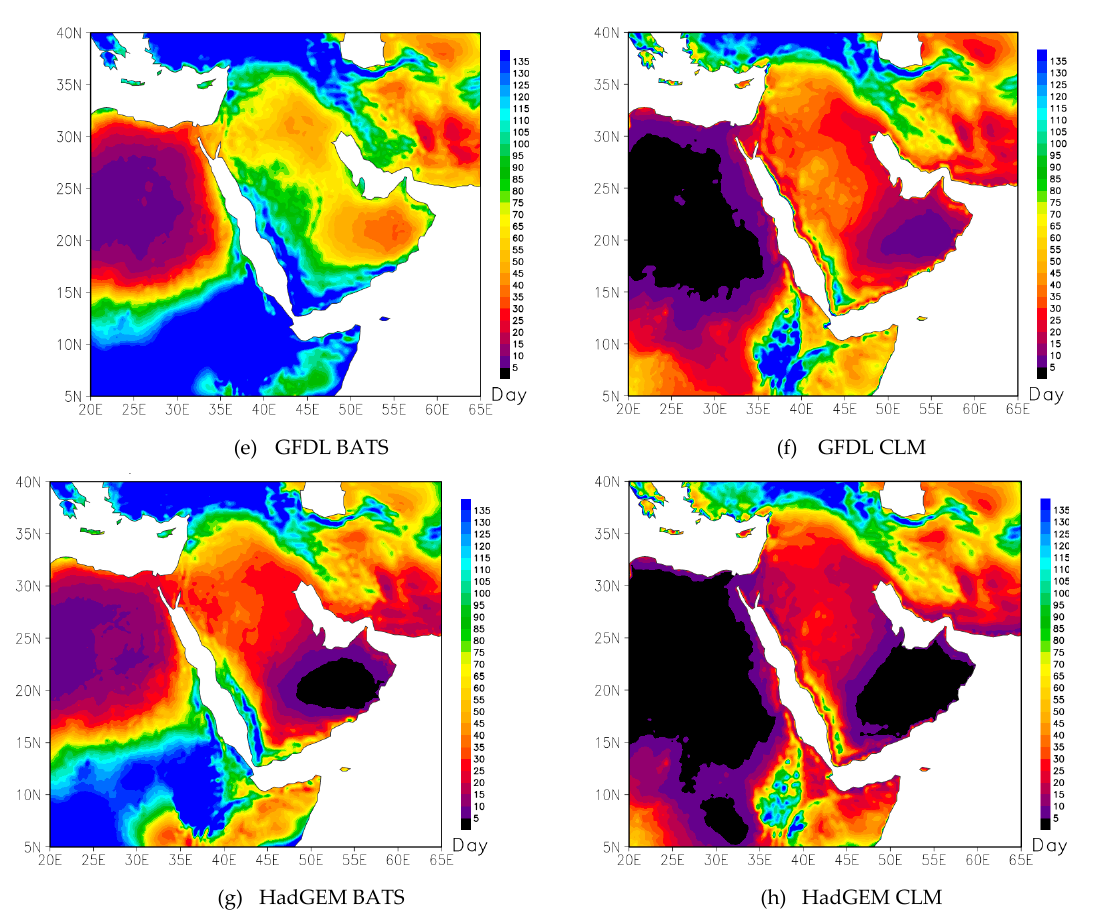
Figure 11. Spatial distribution of the number of annual wet days (R1mm) for ( a ) ERA – Int BATS, ( b ) ERA – Int CLM, ( c ) ECHAM6 BATS, ( d ) ECHAM6 CLM, ( e ) GFDL BATS, ( f ) GFDL CLM, ( g ) HadGEM